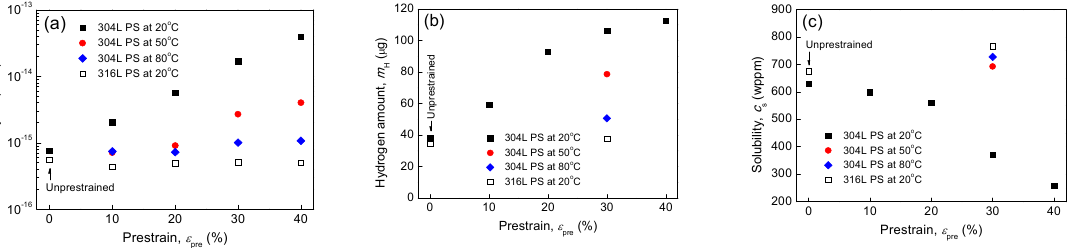
Figure 10. Apparent hydrogen diffusivity ( a ), total hydrogen amount ( b ), and apparent solubility ( c ) of un ‐ prestrained and prestrained (PS) specimens as functions of prestrain level and temperature.